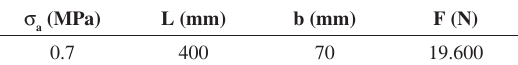
Table 5. Force from the autoclave over to coupon surface.